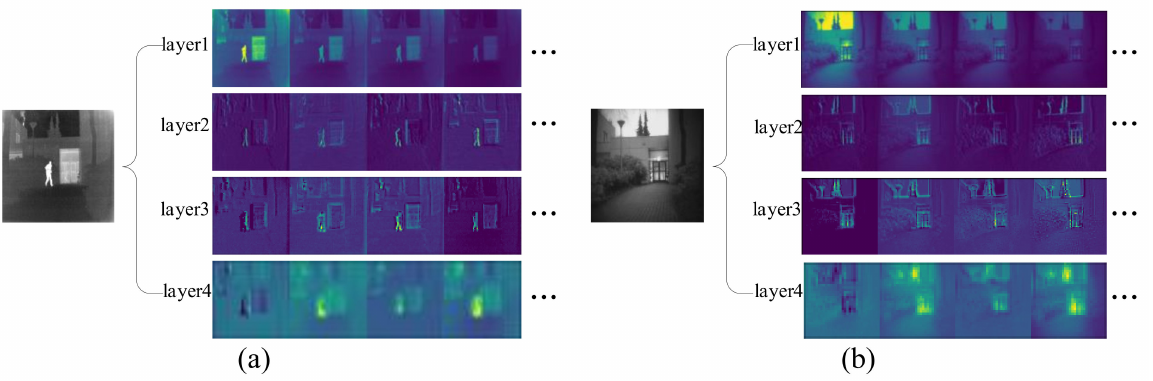
Figure 2. Multi-modal features extracted by encoder. ( a ) shows the features extracted from infrared image, ( b ) shows the features extracted from visible